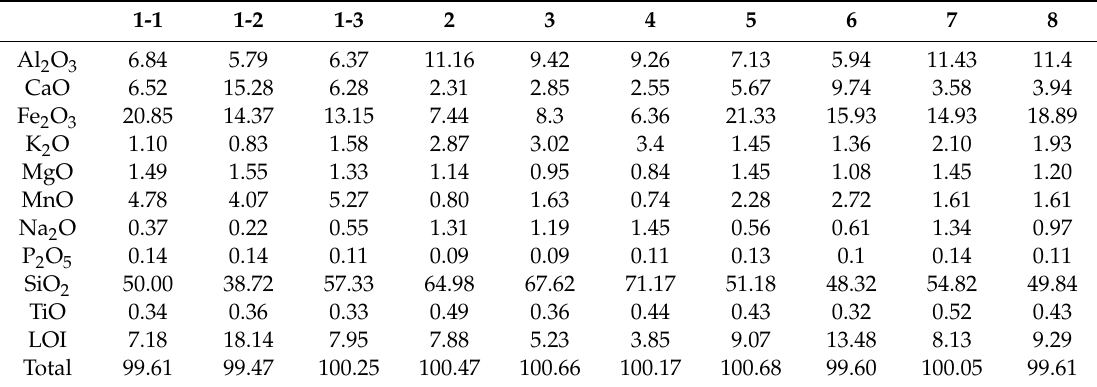
Table 3. Chemical composition of the mine tailings